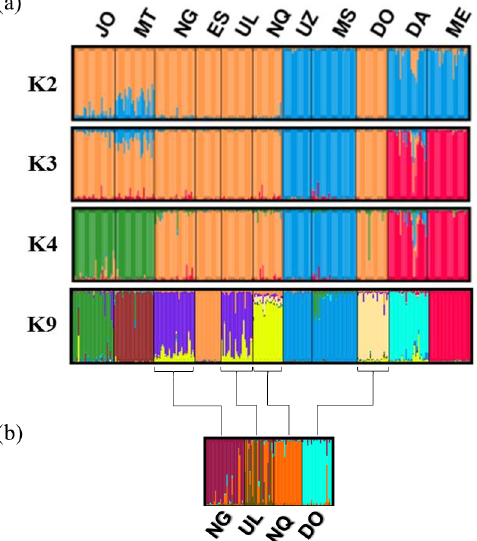
detected at K = 4 (S2A Fig). The Q-matrix averaged over the most similar run for K = 4, was used to display in a map the distribution of membership coefficients according to population and geographical location (Fig 3). As shown in Fig 2, at K = 2, two clusters were formed; UZ, MS, DA and ME clustered together, while JO, NG, ES, UL, NQ and DO formed a second clus- ter. MT appeared as an admixture between the two clusters. At K = 3, DA and ME clustered together separately. At K = 4, four different clusters were defined; the first cluster (JO and